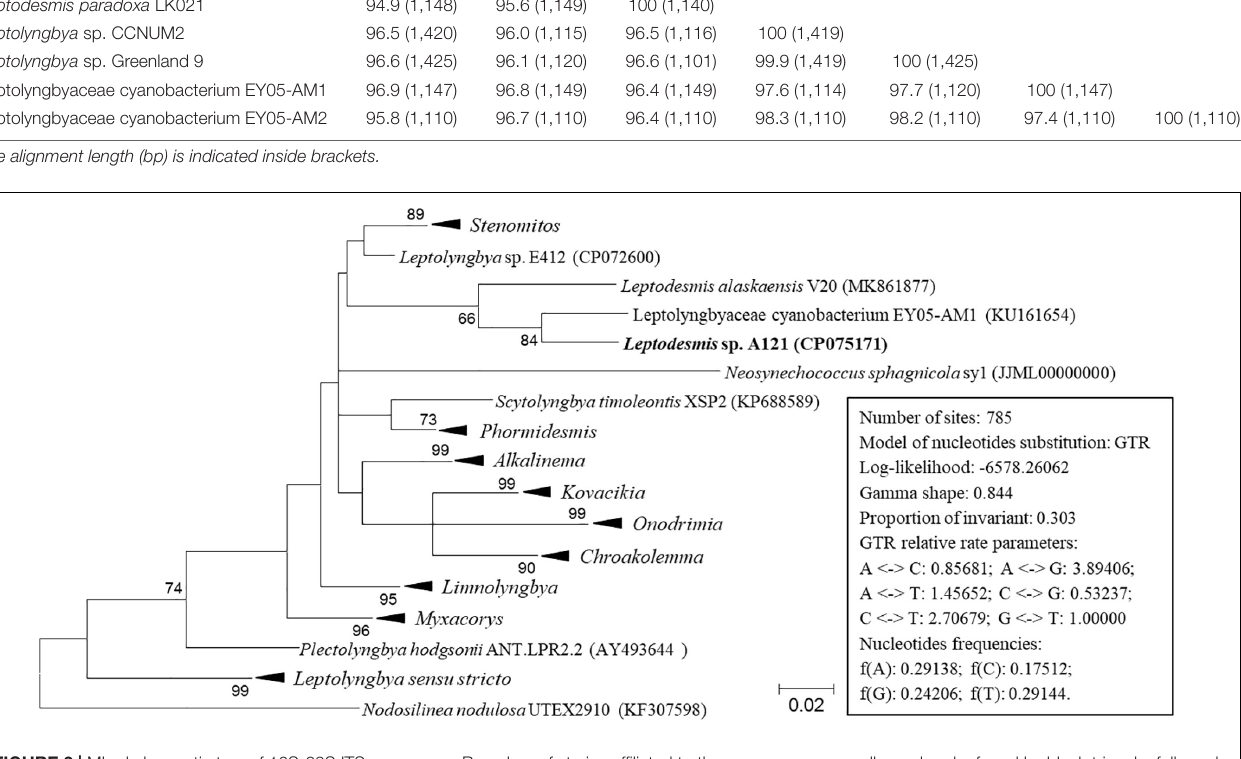
FIGURE 3 | ML phylogenetic tree of 16S-23S ITS sequences. Branches of strains affiliated to the same genus are collapsed and referred by black triangle, followed by the genus name. The complete tree is shown in Supplementary Figure 2 . Only bootstrap values > 50% are indicated at nodes. Scale bar = 2% substitutions per site. TABLE 2 | The length (bp) summary of regions within16S-23S ITS of Leptodesmis strains studied.